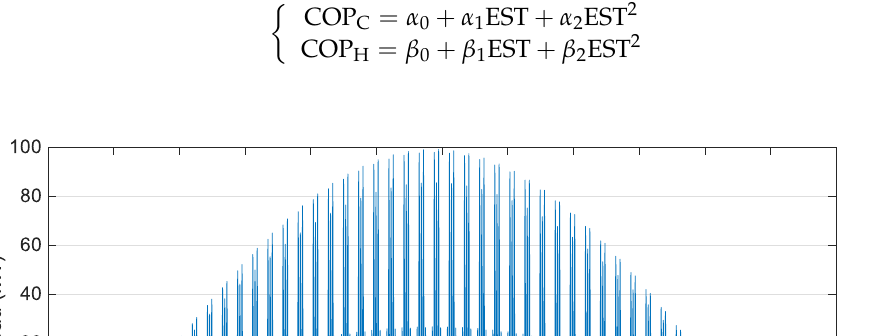
Figure 6. Heat pump EST-COP curve for heating and cooling operations. Table 5. Comparison of the heat pump performance data for the ASHP-PDHP simulation. i